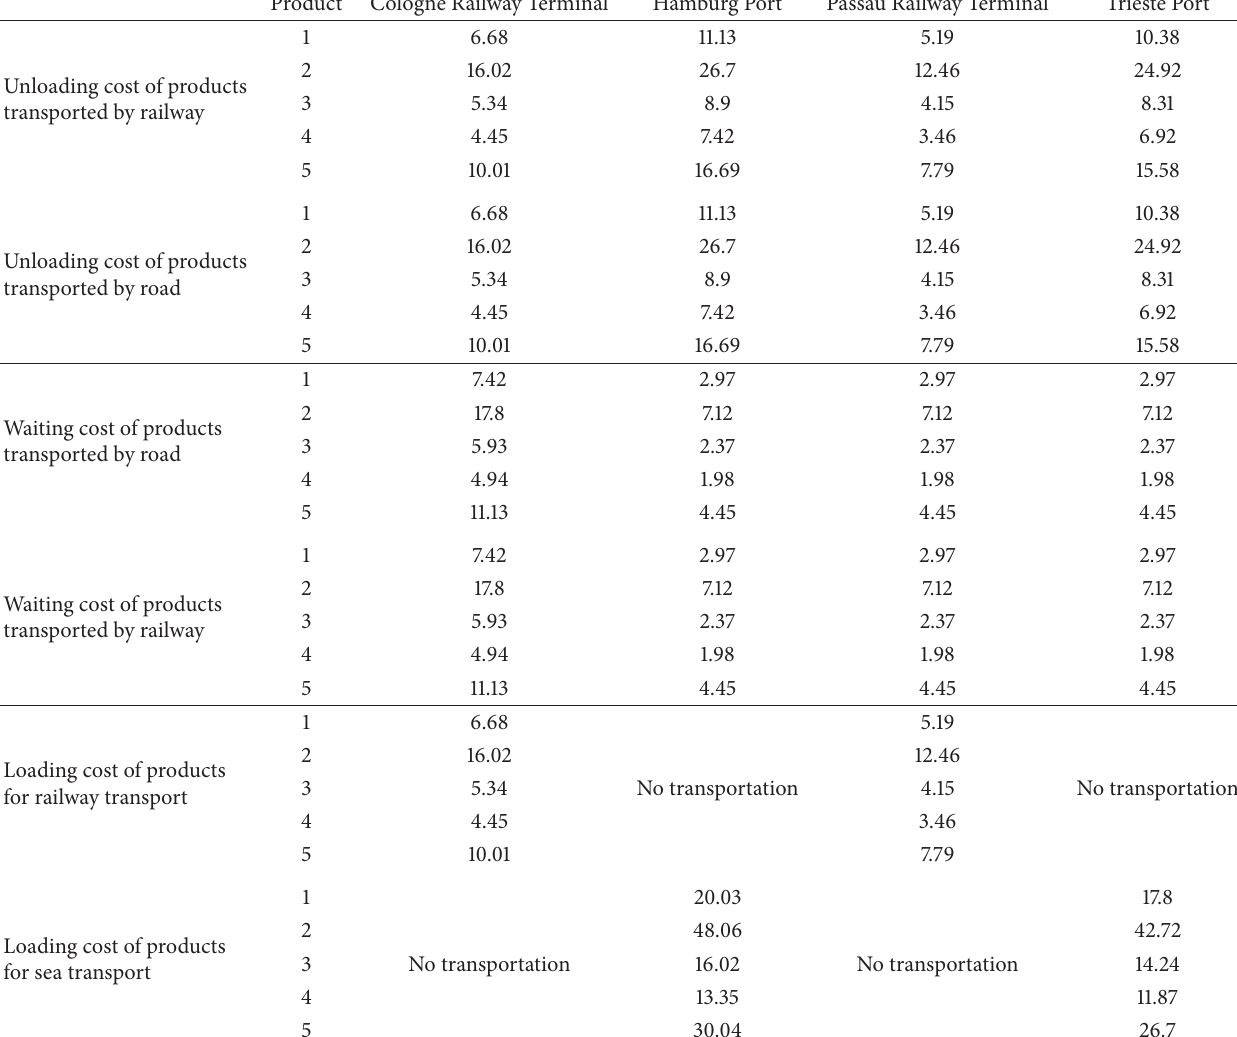
Table 10: Product based unloading, warehousing, and loading costs in the first transshipment terminals (TL/product).